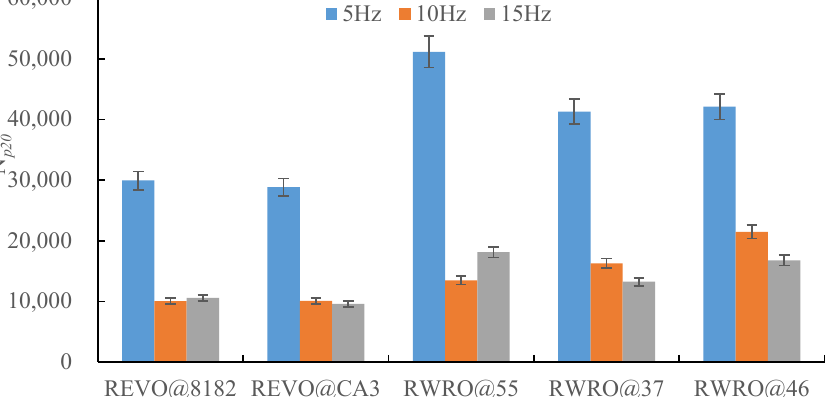
Figure 10. Fatigue life of rejuvenated asphalt under different loading frequencies. Table 10. Fatigue life change rate at different loading frequencies.